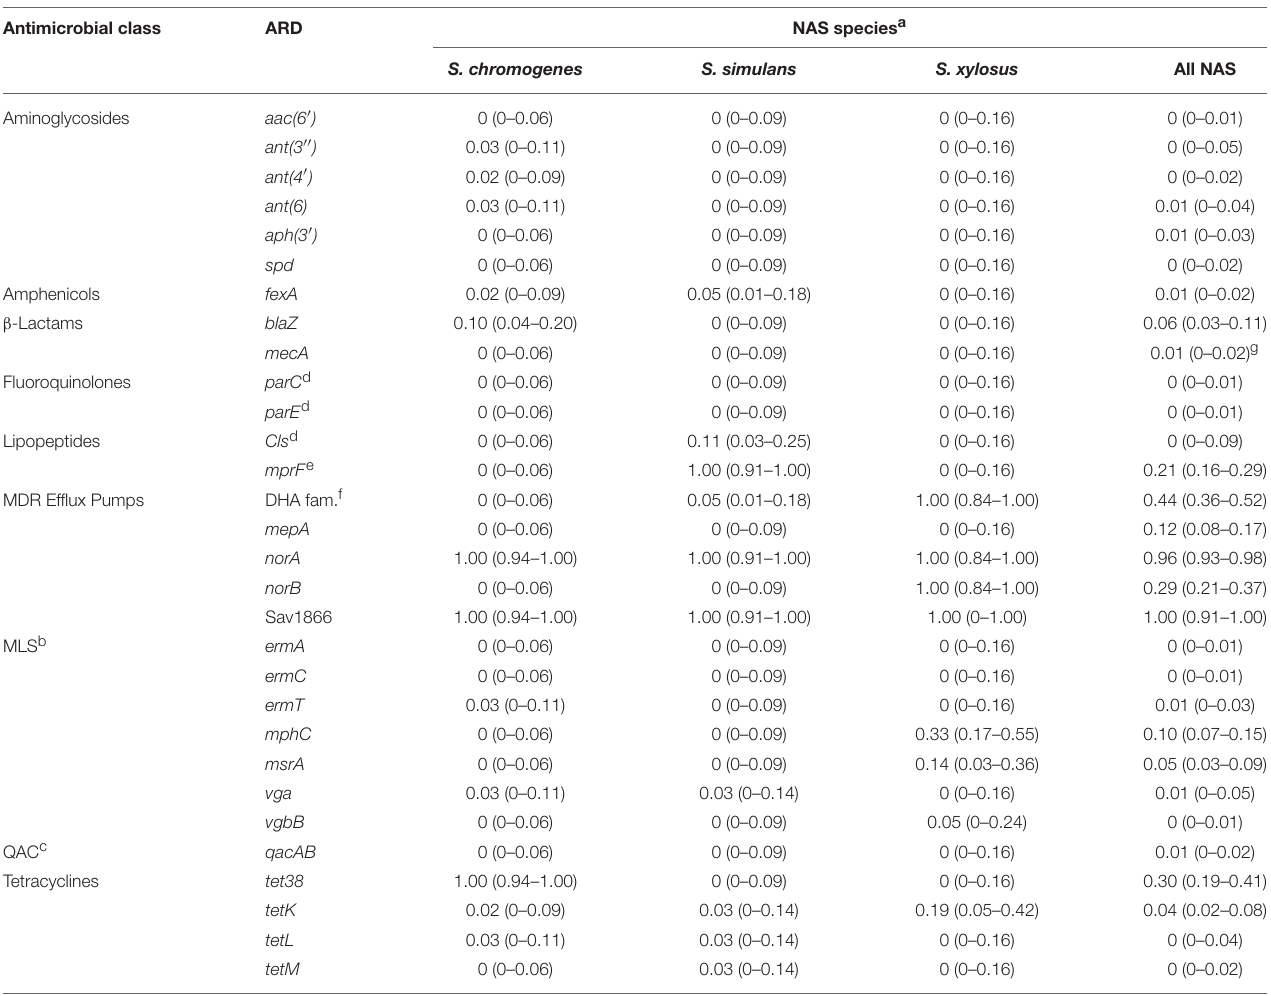
TABLE 2 | Prevalence (and 95% confidence interval) of antimicrobial resistance determinants (ARDs) per isolate associated with various antimicrobial classes in the 3 most frequently isolated bovine non- aureus staphylococci (NAS) species. Antimicrobial